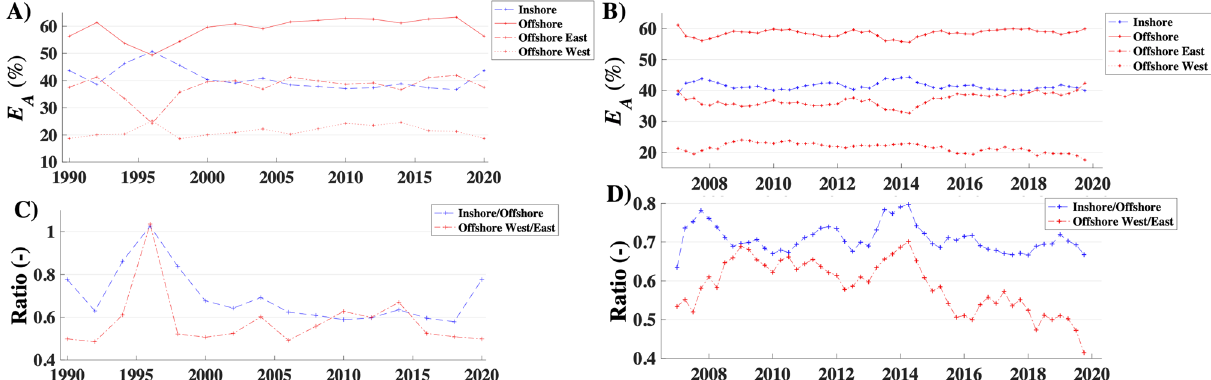
Figure 9. ( A ) Inshore, offshore, offshore east, and offshore west trends 1990–2020 and ( B ) 2008–2020. ( C ) Ratios of inshore to offshore and offshore east to west for 1990–2020 and ( D ) 2008–2020. 1990–2020 simulation run for 2-yr windows with 0% overlap, 22/56-m hybrid sonar grid (Fig. 7); 2007–2020 simulation run for 1-yr window with 75% overlap; 56-m sonar